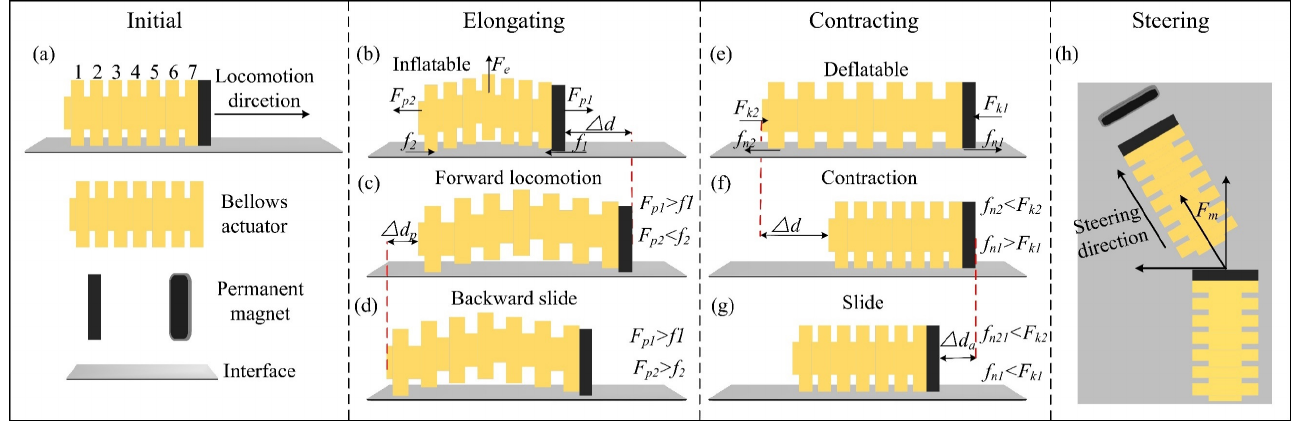
Figure 5. The mechanical theory and motion state of the worm-like robot ( a ) Initial state of the robot; ( b ) Initial inflation with without motion; ( c ) Forward movement; ( d ) Backward extension; ( e ) Deflation; ( f ) Forward contraction; ( g ) Sliding movement; ( h ) Magnetic field steering.